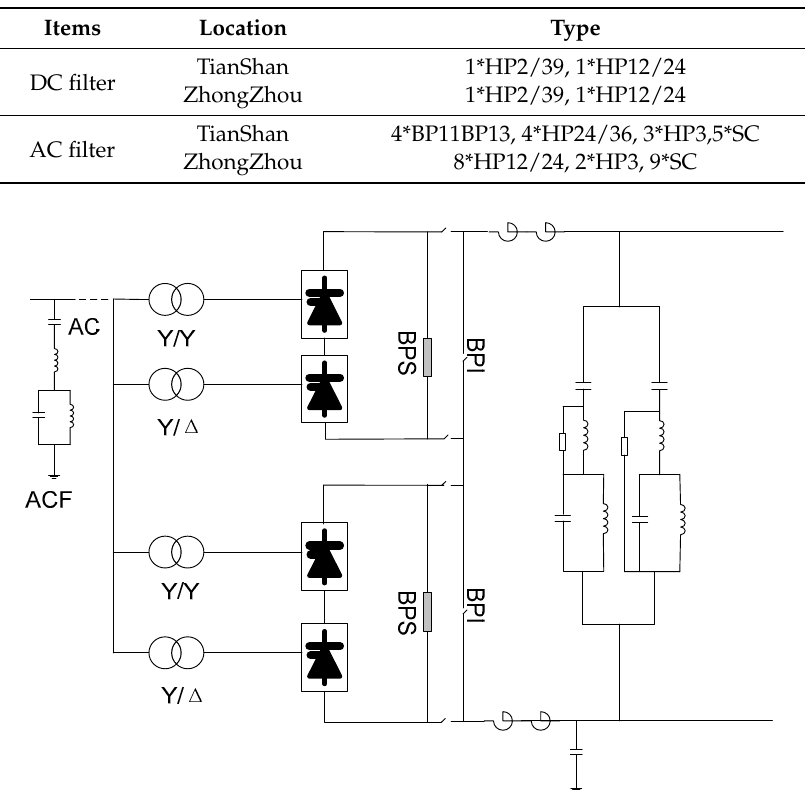
Table 2. The AC/DC filter of TianZhong ± 800 kV UHVDC.